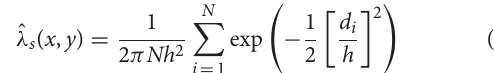
FIGURE 4 | The conditional probability of vent opening at each of the 1,221 simulated vent locations, where color is mapped to P ( vent kernel density estimation method of Connor and Hill (1995). The small black boxes mark the approximate locations of the school (left) and geothermal power station (right) . Coordinates are in meters, web mercator projection (ESPG: